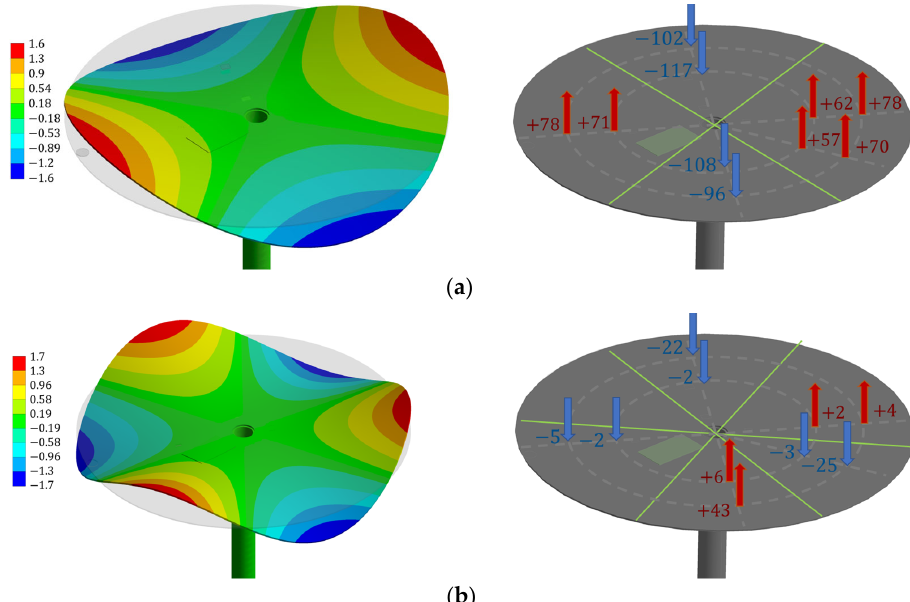
Figure 9. Numerical frequency response obtained from a harmonic analysis when the disk was not rotating in air.